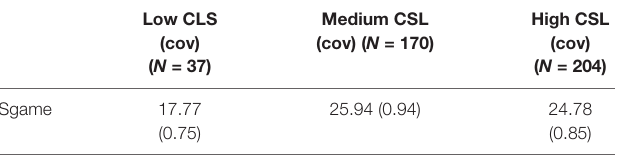
TABLE 4 | Relationships between CSL groups and game performance.